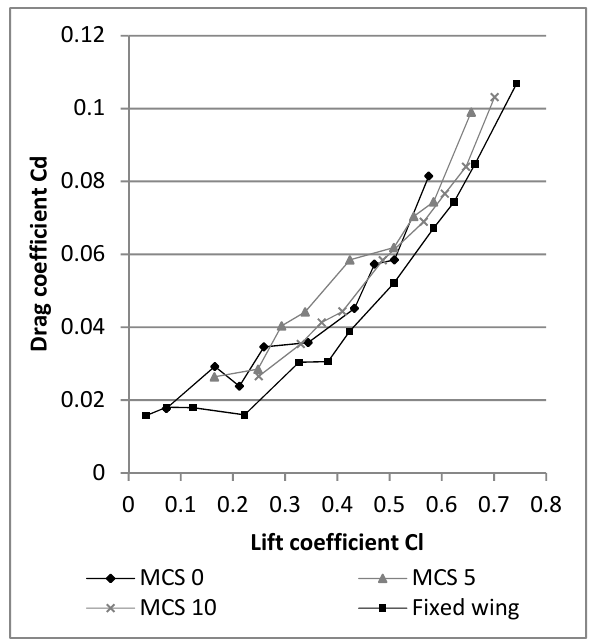
ffi cient variation with the lift coe ffi cient variation. Figure 20. Drag coefficient variation with the lift coefficient variation. Figure 20. Drag coe